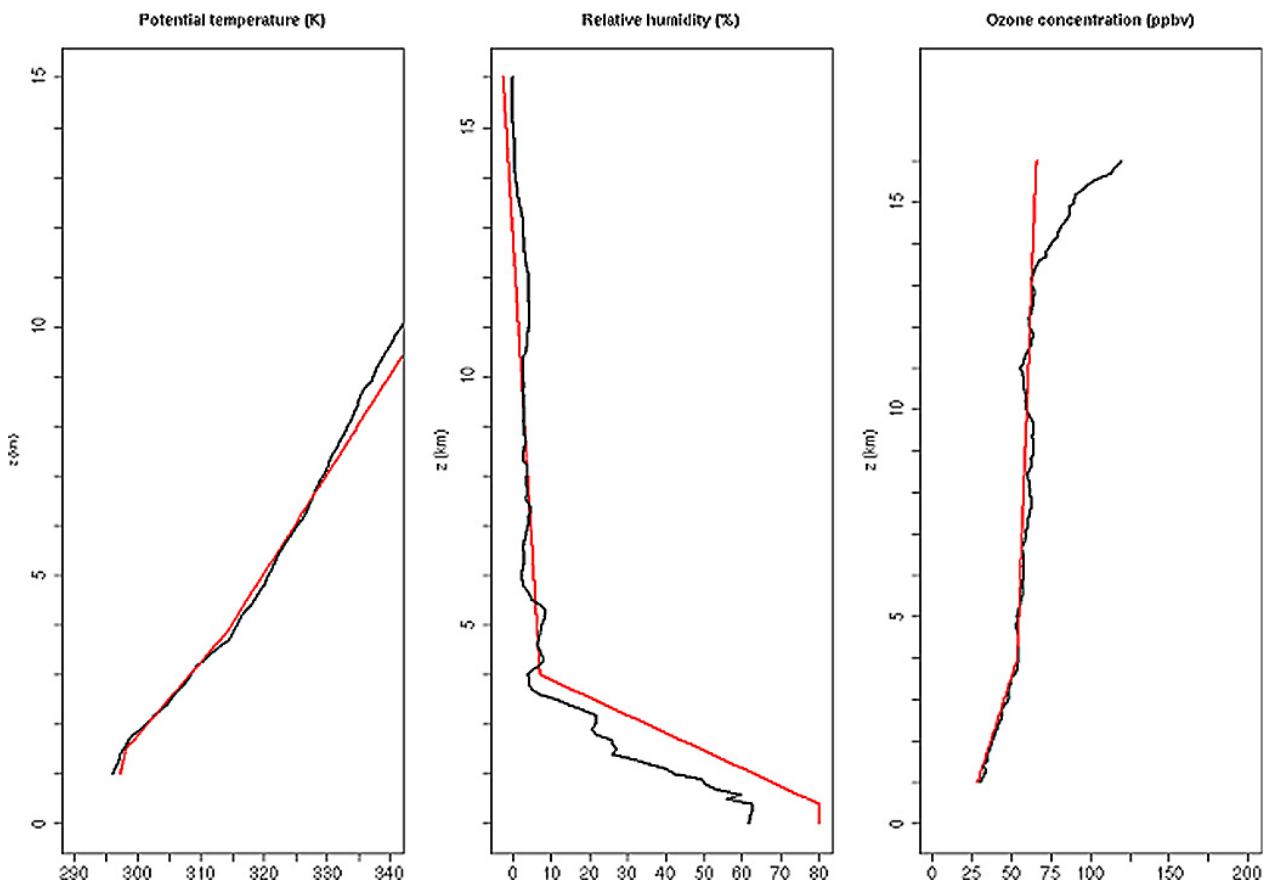
Fig. 3. Mean vertical profiles of potential temperature (K), relative humidity (%) and O 3 (ppbv) during austral winter (black curves) and modelisation (red